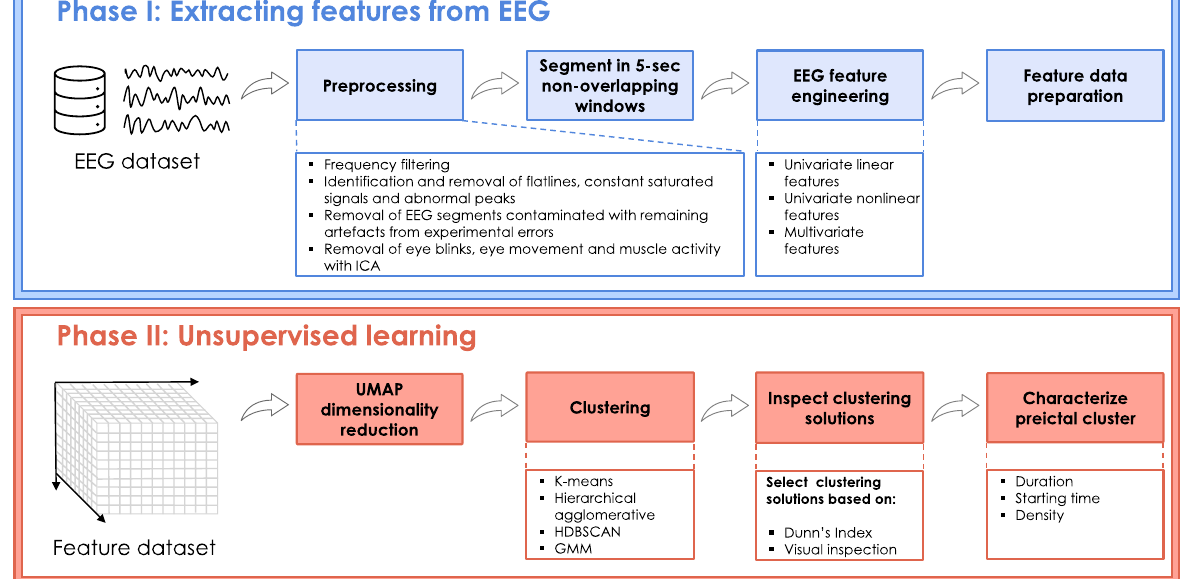
Figure 1. Block diagram of the proposed methodology. The study’s first phase corresponded to preprocessing and feature engineering and preparation. The second phase encompassed dimensionality reduction of each feature group (univariate linear, univariate nonlinear and multivariate), followed by the application of unsupervised learning methods and the preictal interval